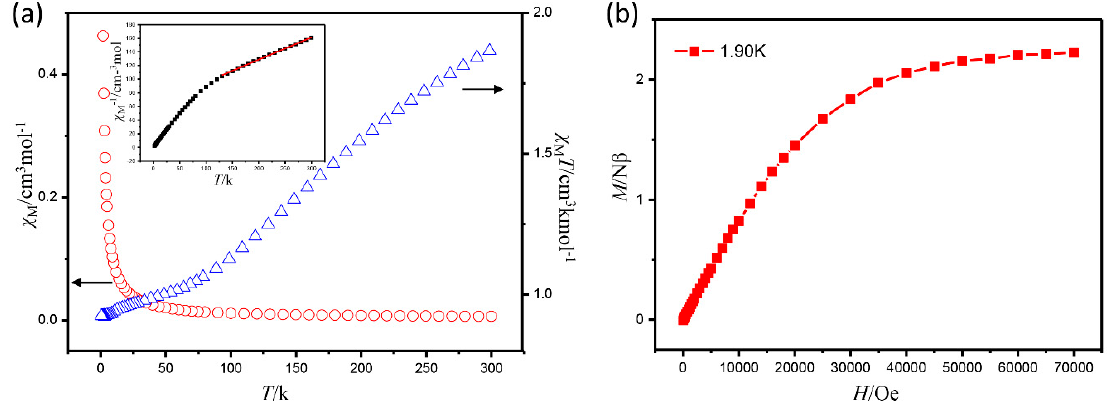
Figure 6. ( a ) Temperature dependence of χ M T ( Δ ), χ M ( ○ ), and χ M − 1 ( □ , inset) for compound 3 with an applied field of 1000 Oe. The solid line corresponds to the theoretical fit of the Curie − Weiss law χ M = C/(T − θ ) . ( b ) Field dependence of magnetization for 3 at 2 K.